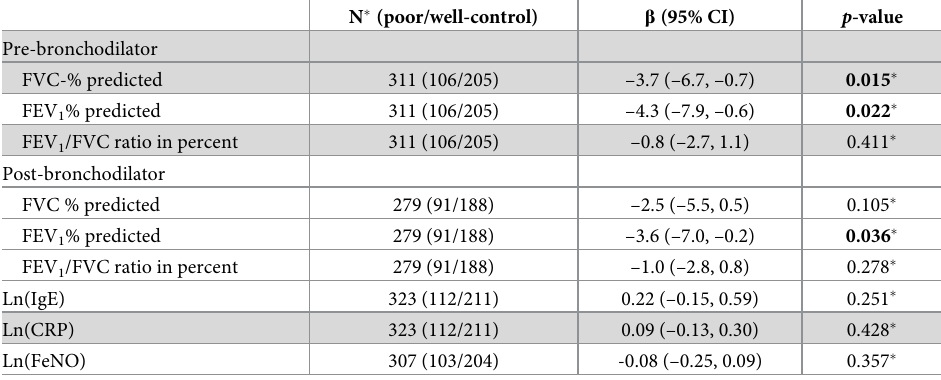
Table 4. Linear regression to identify clinical differences between poor and well controlled asthma